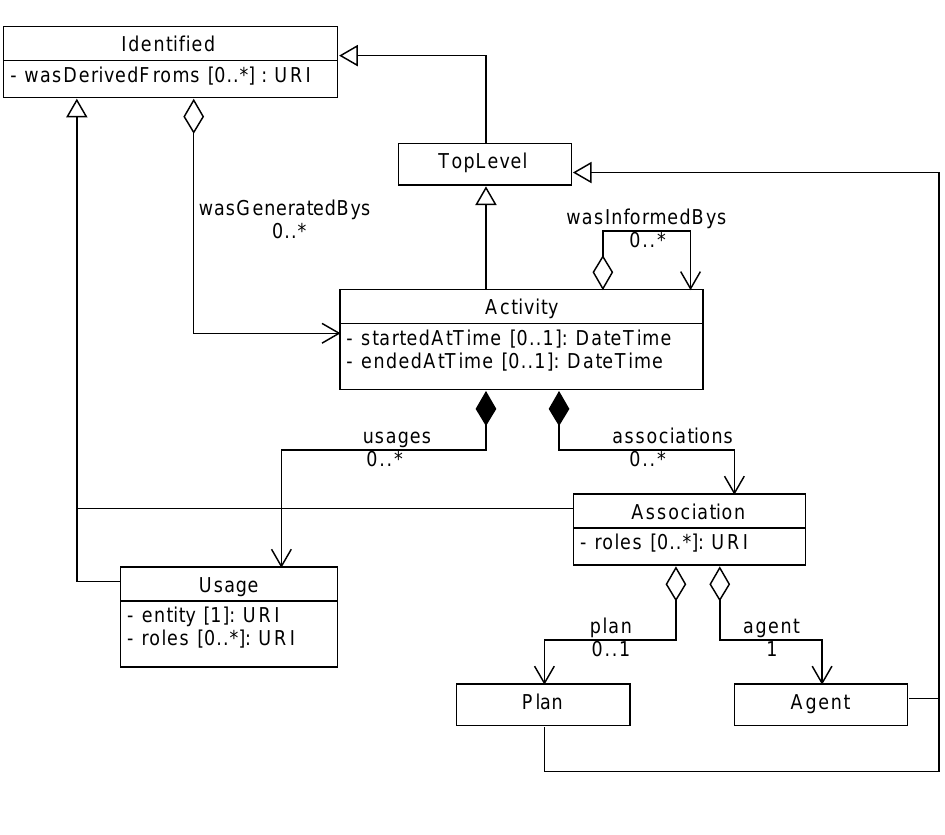
Figure 33: Relationships between SBOL and PROV-O classes. The PROV-O classes Activity , Plan , and Agent are all serialized as TopLevel classes in an SBOL